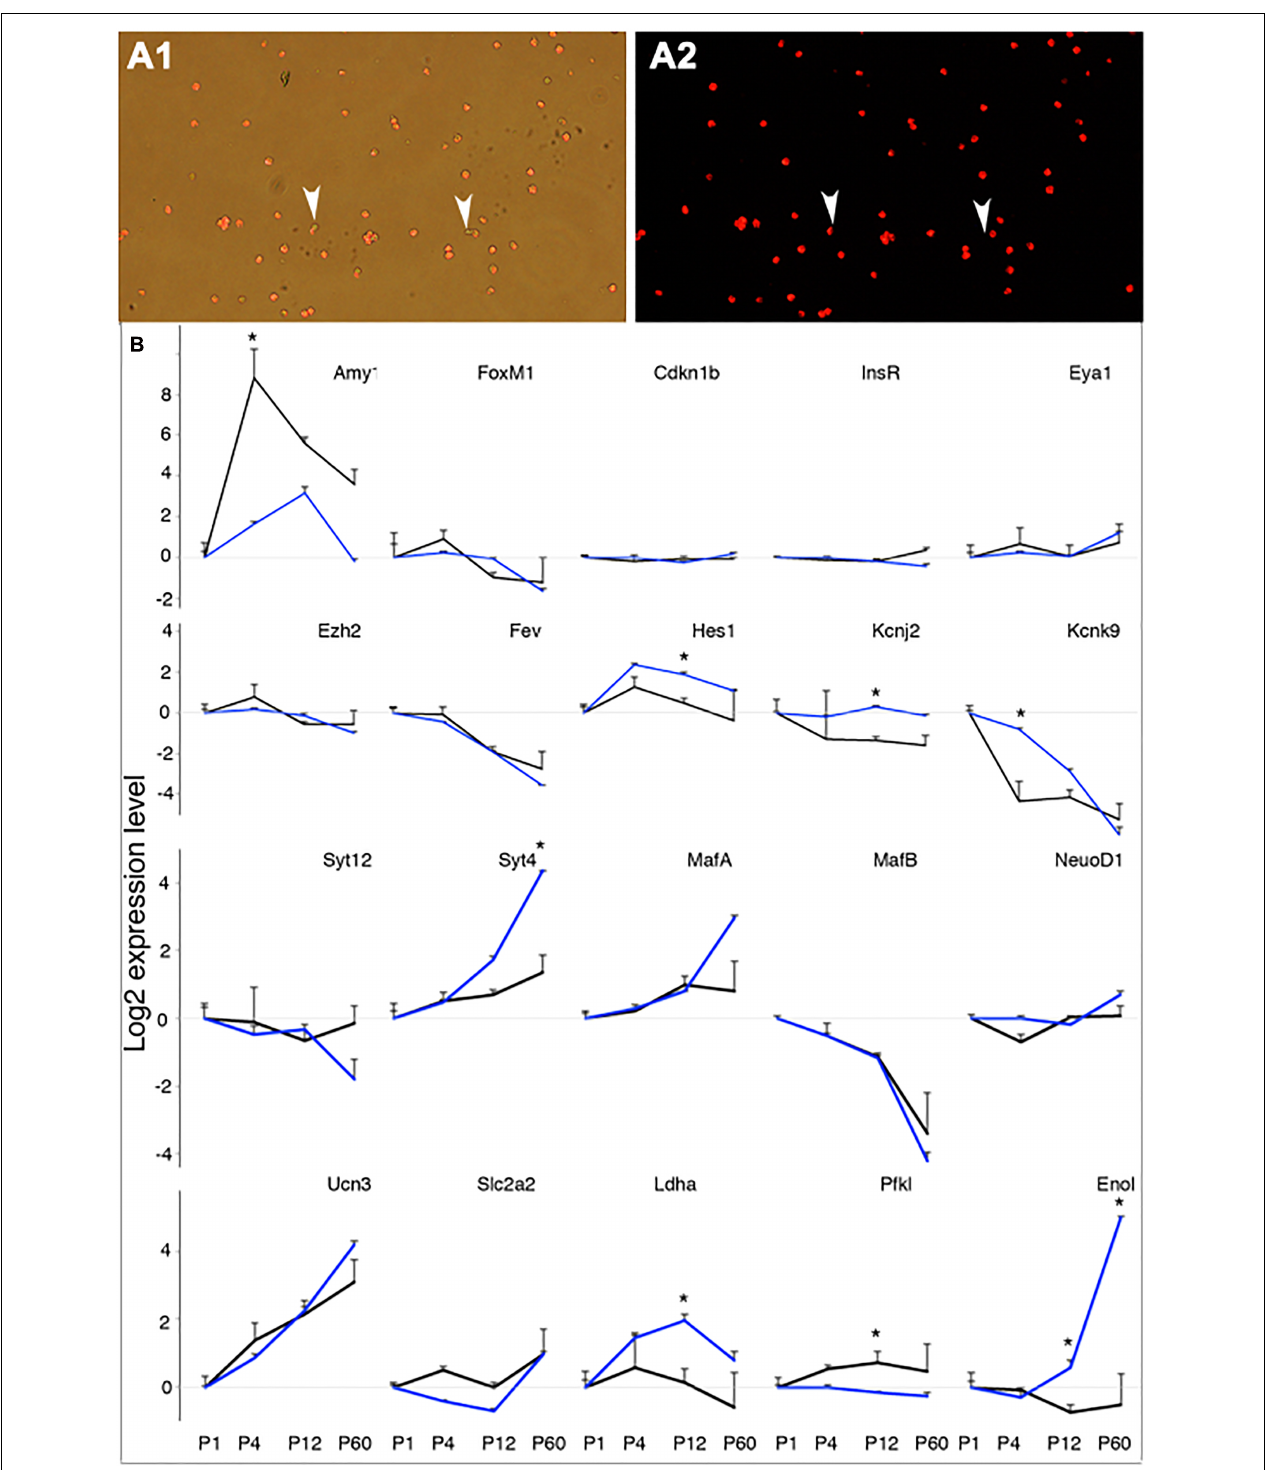
FIGURE 2 | Verification of RNAseq data with RT-PCR in P1-P60 beta cells. The gene expression in P1 beta cells was used as a reference point for other stages. (A) An example of sorted P4 beta cells from Rip mCherry mice. Note the two mCherry-negative cells (arrowheads) in the sorted population. (B) The expression levels of 20 genes, assayed with RT-PCR in Rip mCherry + cells (black lines) and RNAseq in Mip eGFP cells (blue lines). * p < 0.05, Wilcoxon rank-sum test. For each time point, three RNA preps [each from one (P60) to three mice (P1 to P12)] were used for RT assays.